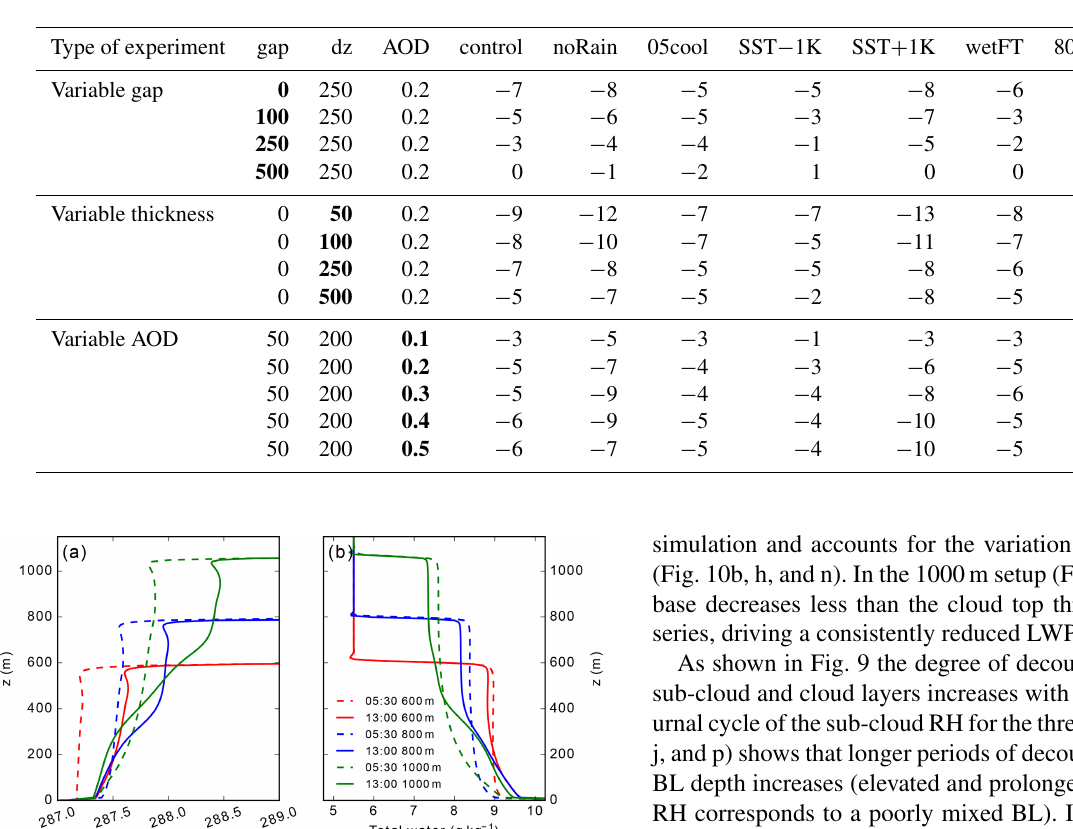
Table 5. Daily mean semi-direct radiative effect for the second day following the introduction of the absorbing aerosol layer for control and cloud sensitivity setups. All values are as a daily mean (Wm − 2 ). Layer properties include the cloud–aerosol gap (“gap”, in metres), the geometric thickness of the layer (“d z ”, in metres), and the aerosol optical depth (AOD) of the layer given at a mid-band wavelength of 505nm. Bold text emphasizes the variable that is being tested in each set of experiments.